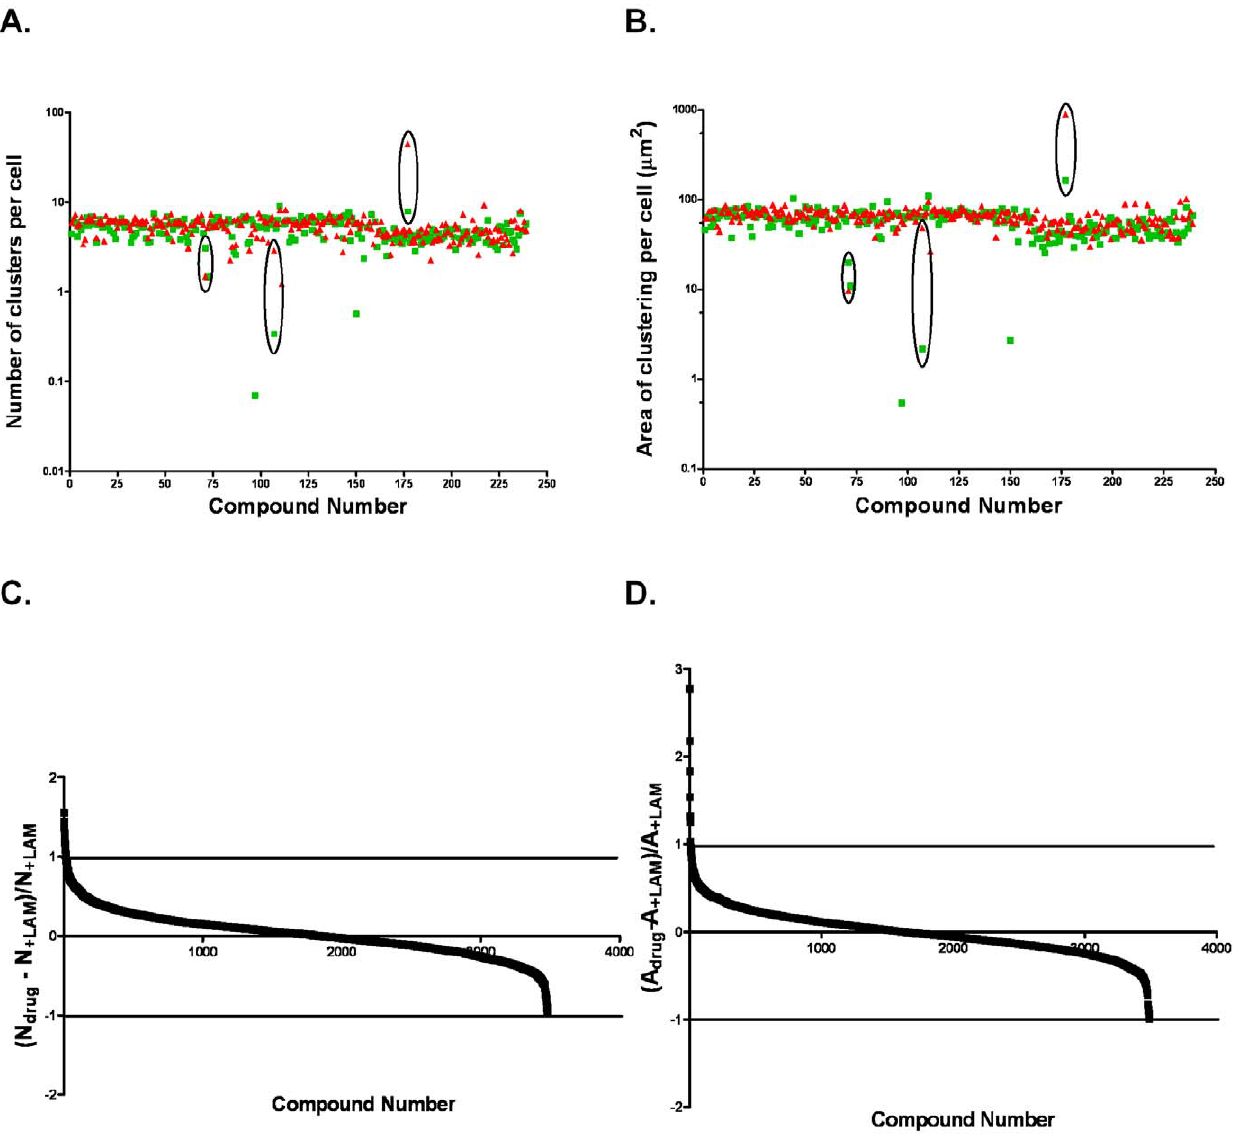
Figure 2. Identification of modulators of ß-dystroglycan clustering using a high throughput screen of a library containing 3,594 drugs. A, B. Duplicate experiments (red and green)from three 96-well plates corresponding to approximately 200 drugs are represented. Drugs inducing a change greater than 1.6 fold in ß-DG clustering in laminin-treated compared to untreated astrocytes in both experiments (as circled in black) were considered effective and used for subsequent testing. C, D. Normalized fold differences in the number and area of the clusters plotted for each of the 3,594 compounds tested.